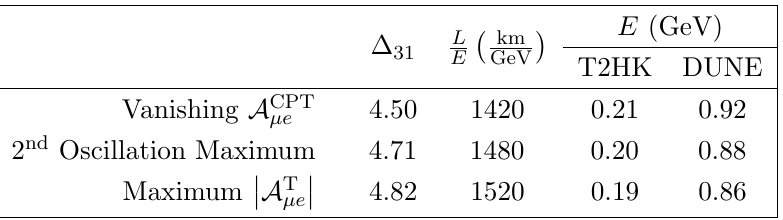
in eq. (6.7), the second vacuum oscillation 0